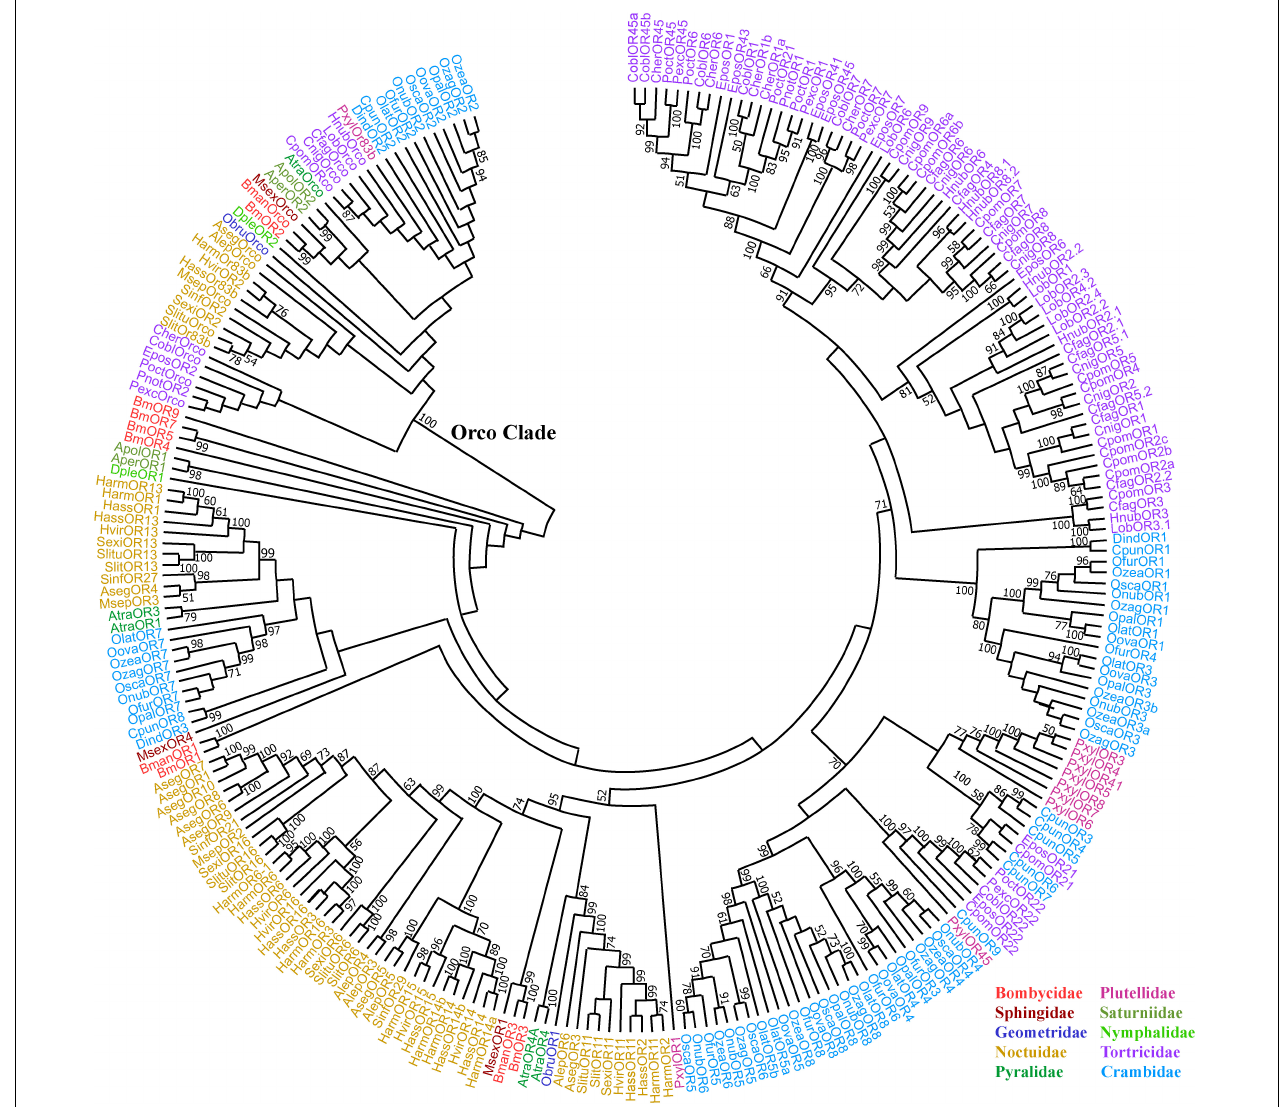
FIGURE 1 | Phylogenetic tree of candidate sex pheromone receptors (SPRs) and Orcos of Lepidopteran insects. Lepidopteran SPR labels and their corresponding family name (at the bottom right corner) are in the same color. Node support was assessed with 1,000 bootstrap replicates, and values greater than 50% are shown. The model used was JTT according to the model prediction by MEGA X, and the neighbor-joining method was used. All the GenBank IDs of receptors are shown in Table 1